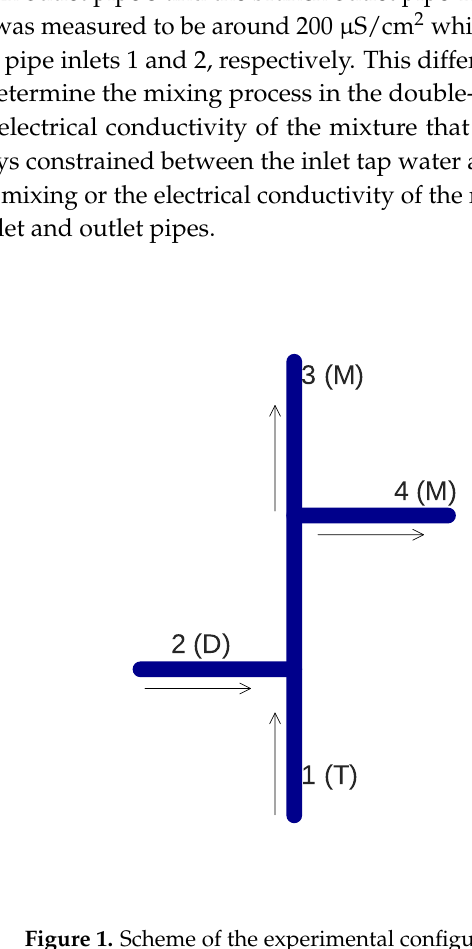
Figure 1. Scheme of the experimental